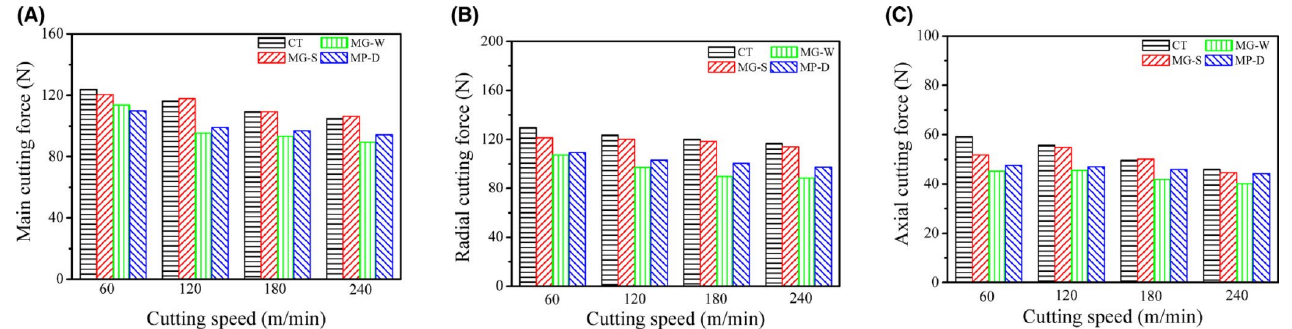
Figure 18. Effect of conventional tools and micro-textured tools on cutting force at speeds varied from 60 to 240 m/min: ( A ) main cutting force; ( B ) radial cutting force; and ( C ) axial cutting force ( a p = 0.2 mm, f = 0.102 mm/r) [75].